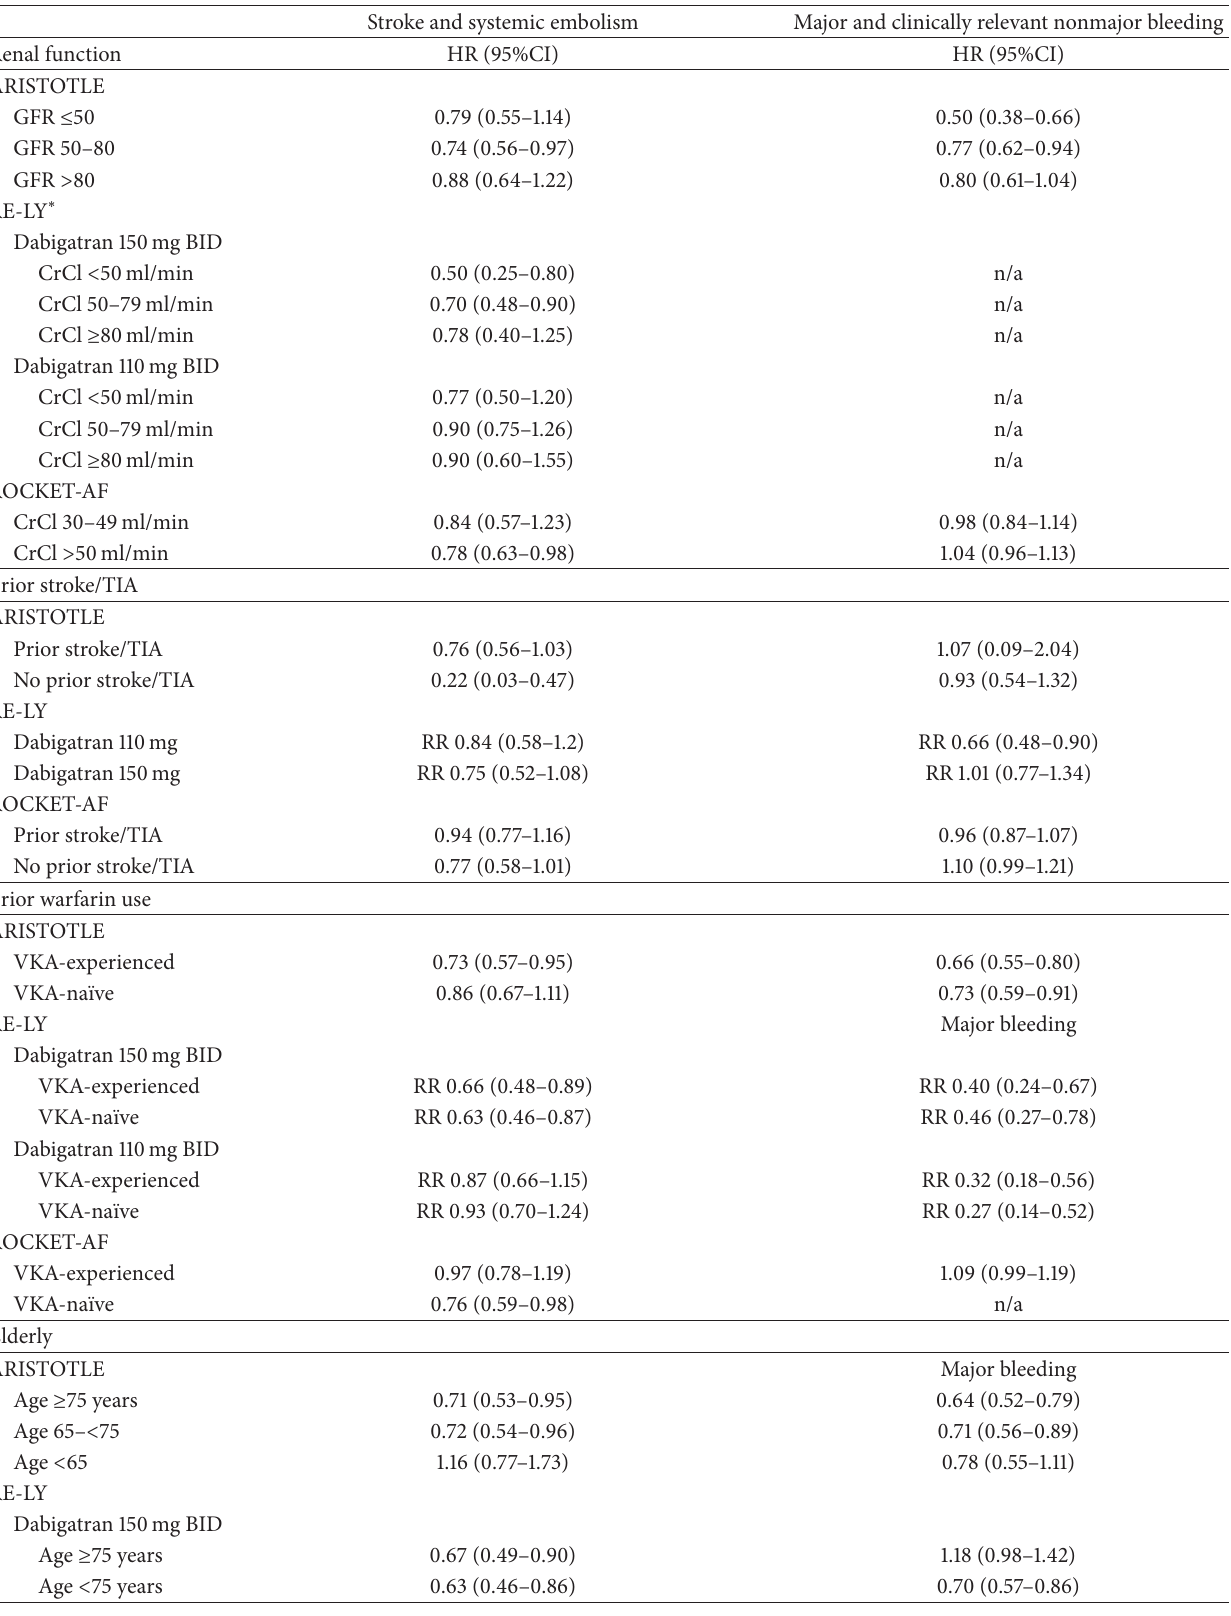
Table 3: Hazard ratios with 95% CI for subgroup analyses for novel agents versus warfarin. Stroke and systemic